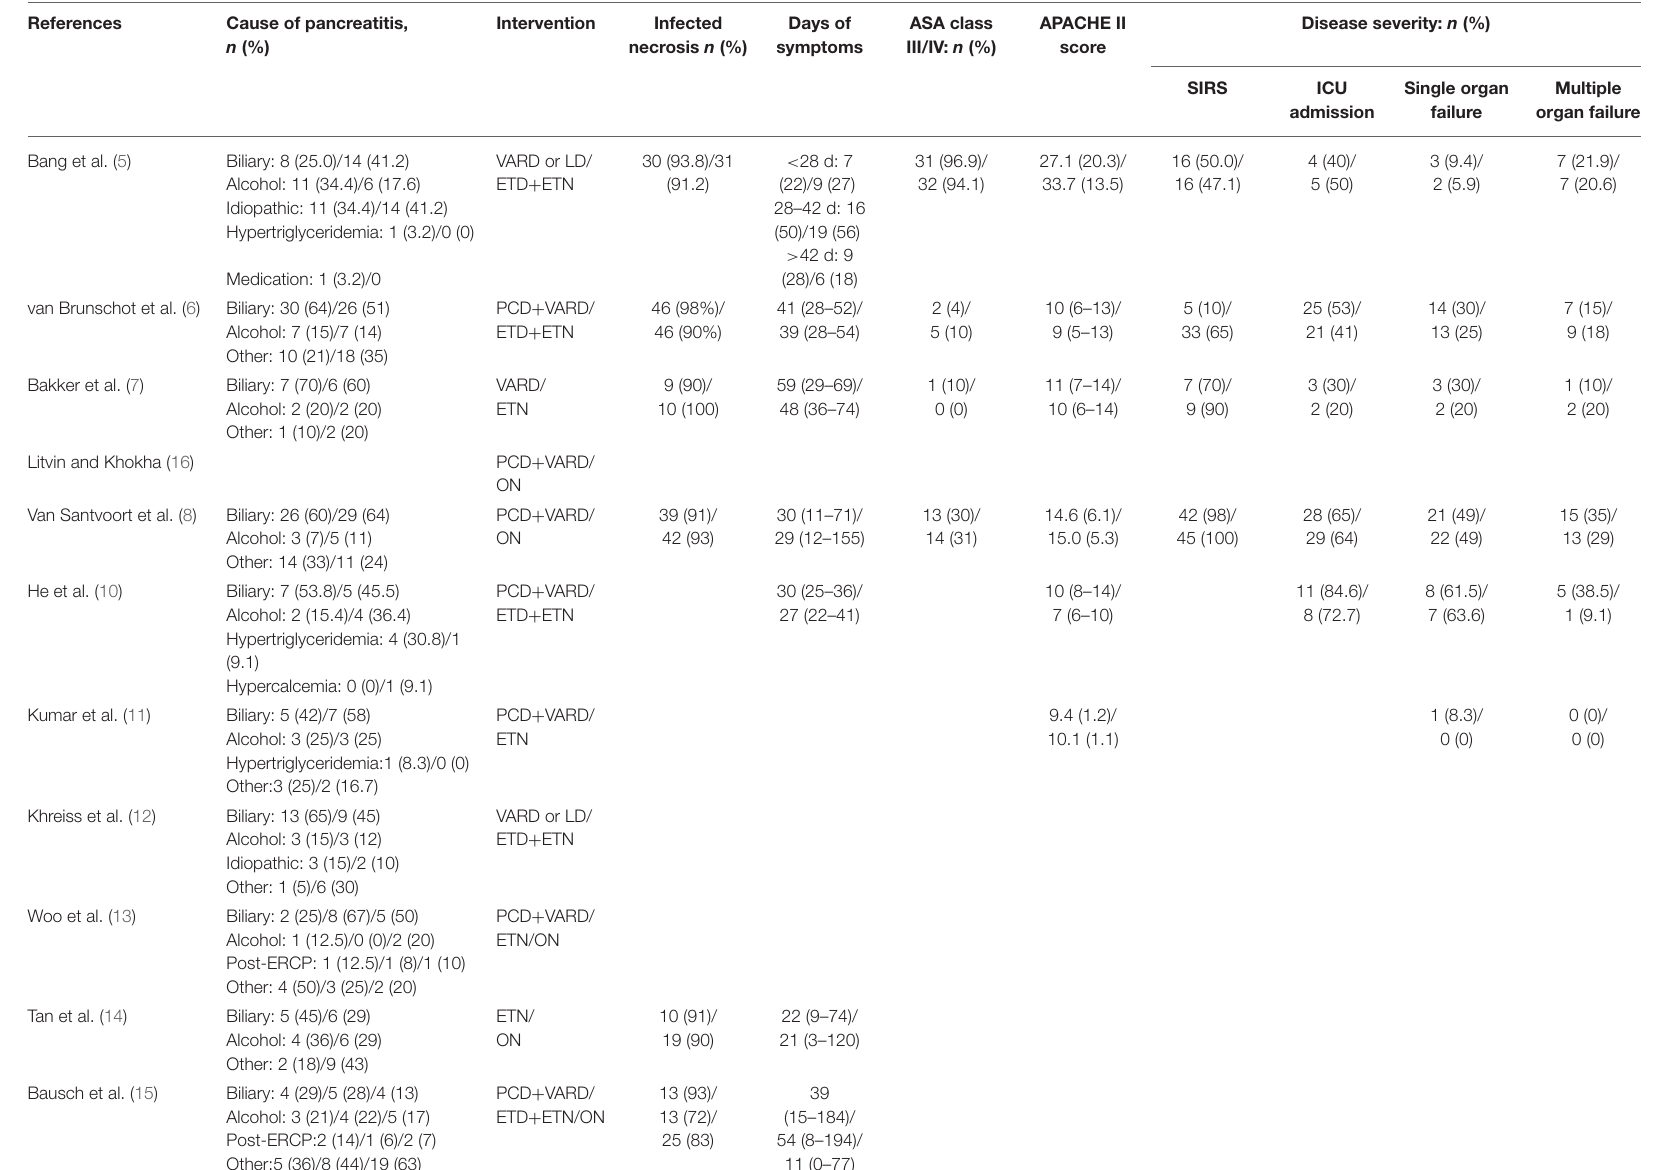
TABLE 2 | Baseline characteristics of the pancreatitis and disease